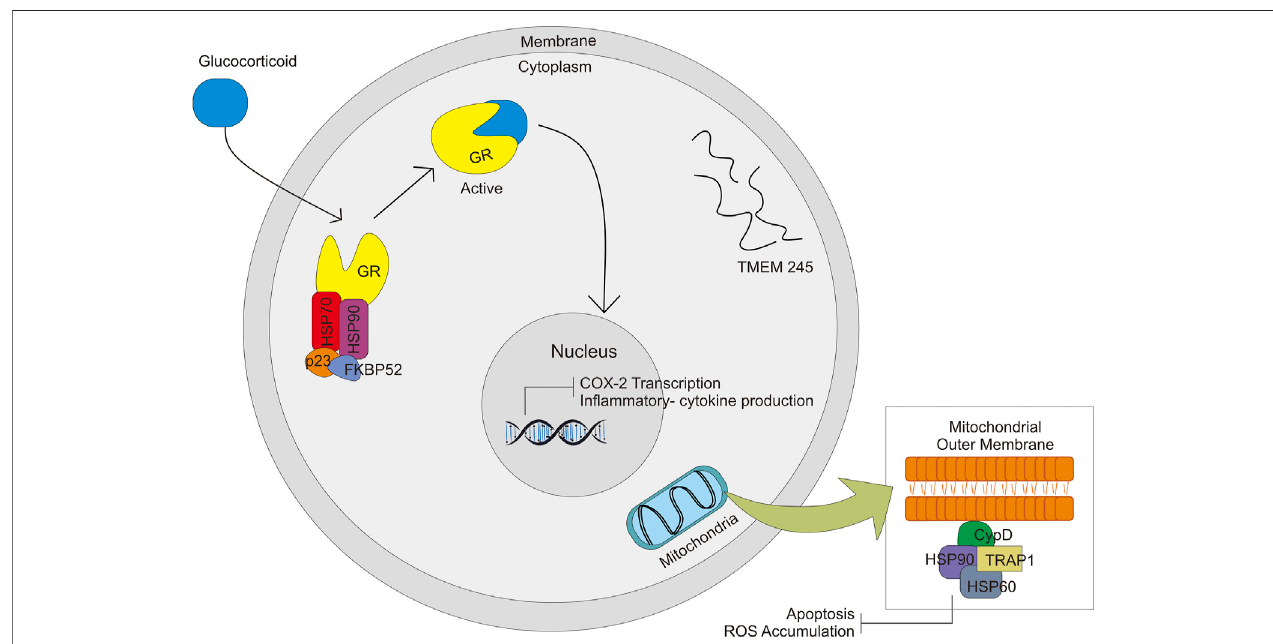
FIGURE4| SignalpathwayactivatedbyGCthroughcomplexformationwithHSP70,HSP90,p23,FKBP52,andGR.GC-GRcomplexformationwillactivateother signals in the nucleus and mitochondria.